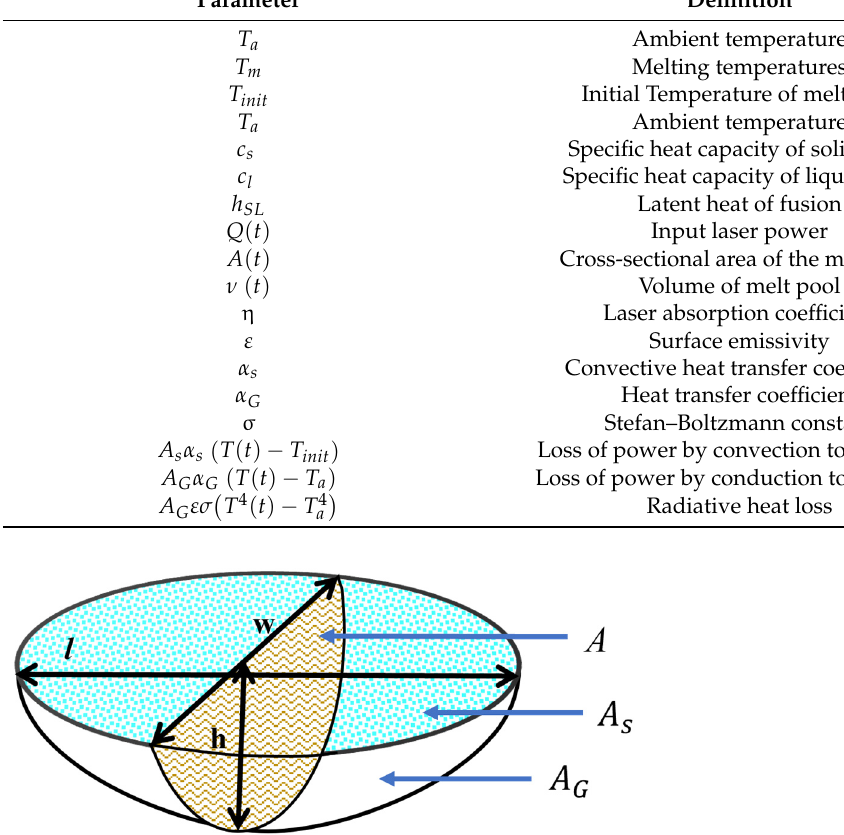
Figure 2. Melt-pool ellipsoidal volume. A is the melt pool cross-sectional area. As represents the melt pool surface area where convection is taking place. A G represents the melt pool surface area in contact with solid metal.